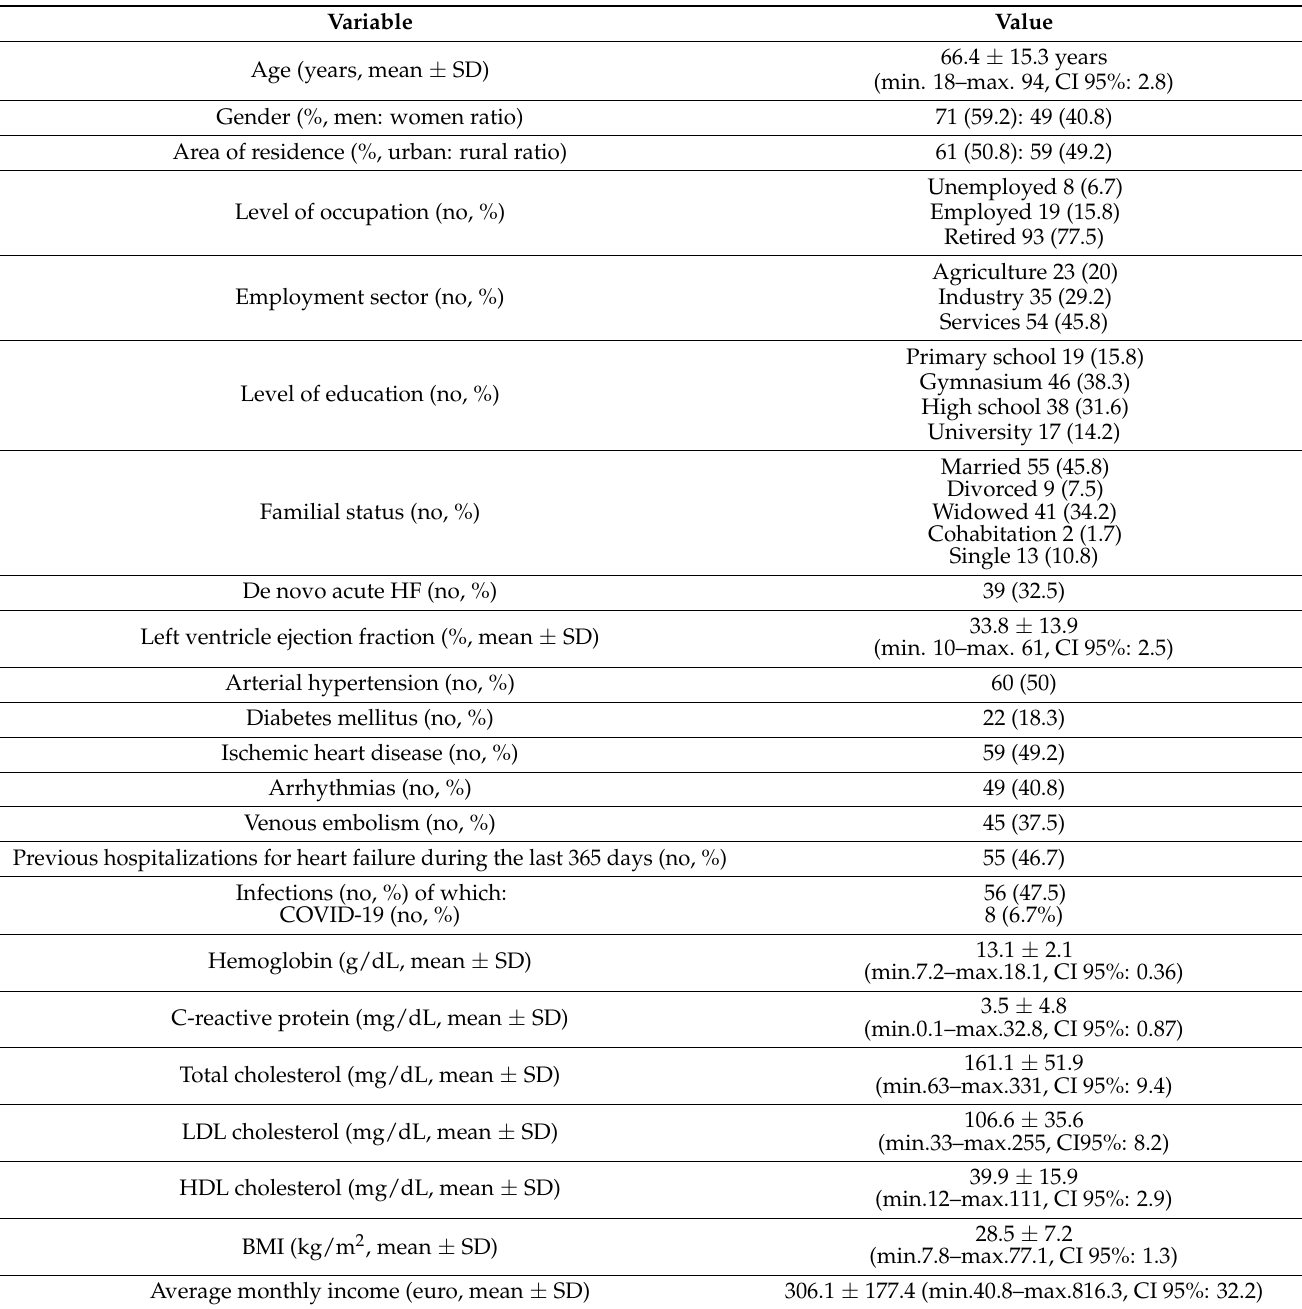
Table 1. Baseline